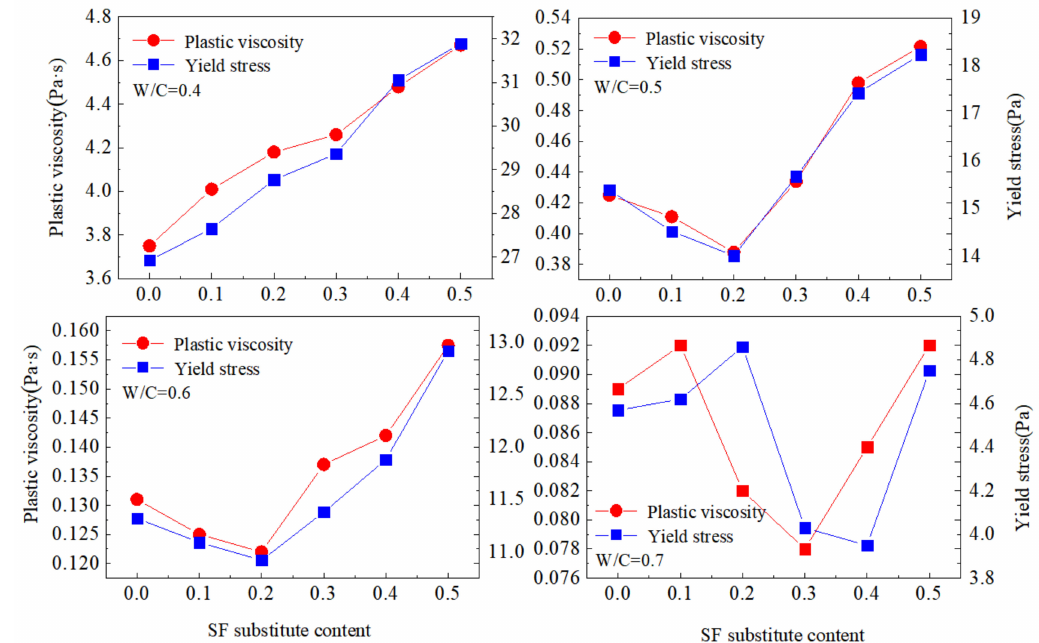
Figure 4. Variations of yield stress and apparent viscosity with w/c at different SF substitute